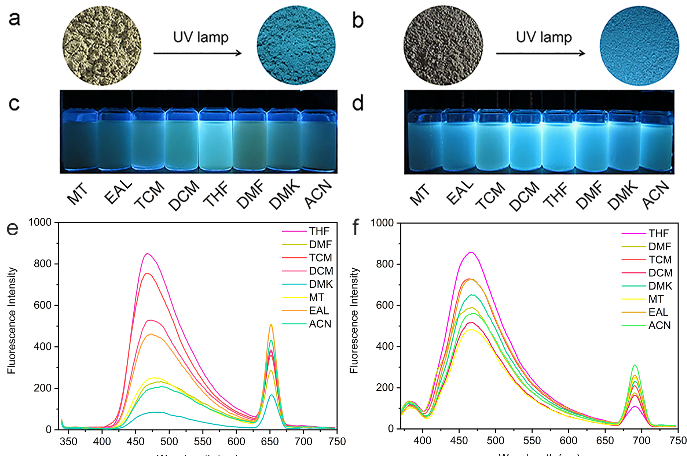
Figure 3. Color change of LNU-45 ( a ) and LNU-47 ( b ) powder before and after UV lamp irradiation (λ ex = 365 nm). LNU-45 ( c ) and LNU-47 ( d ) dispersed in different organic solvents under UV light (λ ex = 365 nm). Fluorescence emission spectra of LNU-45 ( e ) and LNU-47 ( f ) dispersed in different organic solvents (0.25 mg mL −1 ).